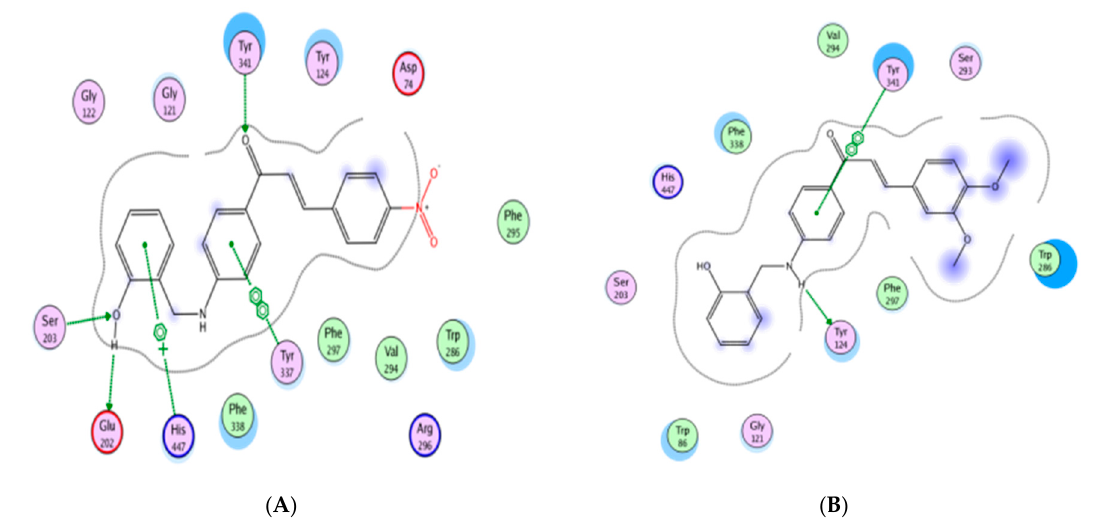
Figure 3. Interactions between A4 and A6 with AChE: ( A ) A4; ( B ) A6.